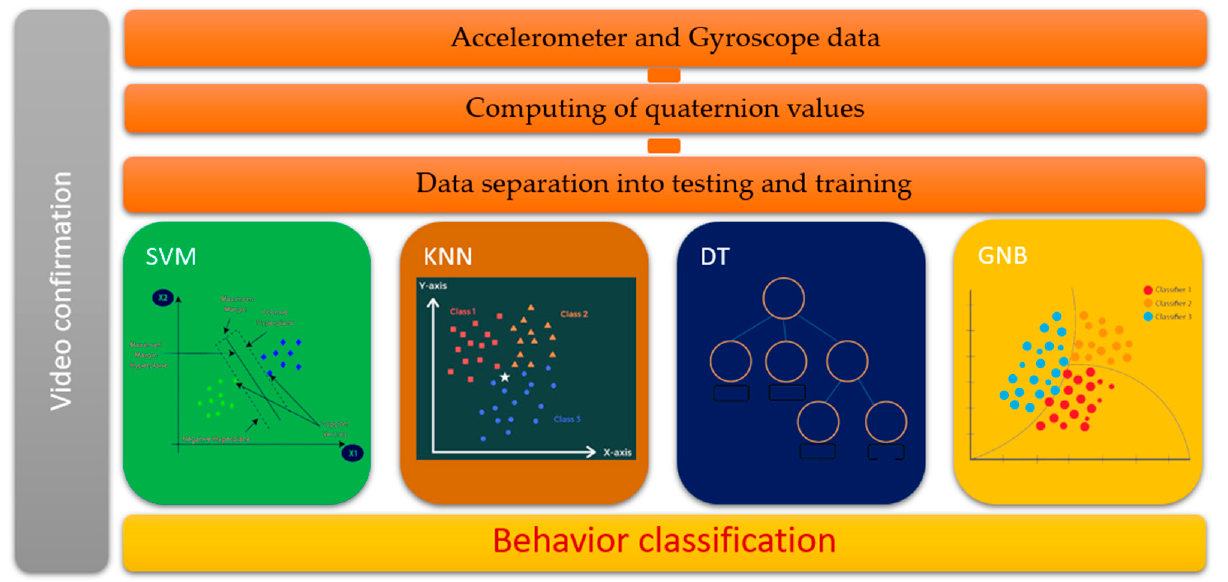
Figure 3. Experimental process model structure for all three classifications .